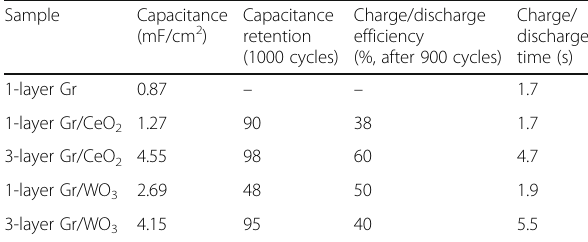
Table 2 Results from the electrochemical characterization of the different hybrid electrodes